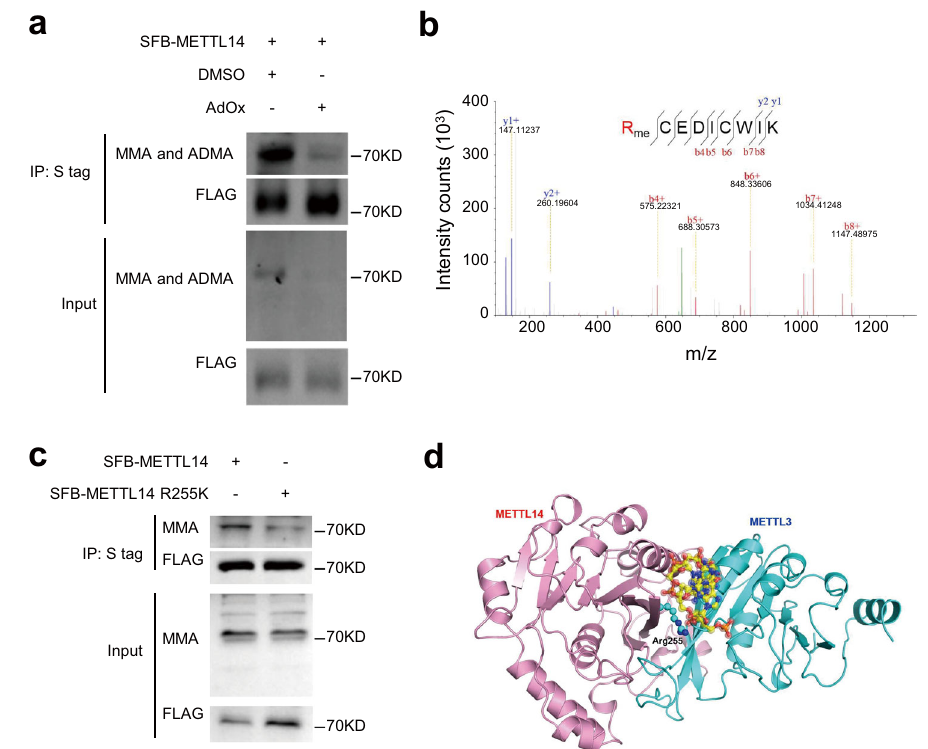
Fig. 1 METTL14 is methylated at arginine 255. a Arginine methylation of immunoprecipitated S-Flag-SBP (SFB) tagged METTL14 protein detected by western blot in HeLa cells. MMA mono-methyl arginine, ADMA asymmetric dimethyl arginine. The experiment was performed once in HeLa cells. b Mass spectrometry showing that METTL14 R255 is methylated. The mass of each b ion and y ion are shown. The mass error of the peptide identi fi cation is 0.26326 ppm. c Arginine mono-methylation of S-Flag-SBP (SFB) tagged METTL14 and METTL14 R255K proteins analyzed by western blot. Representative fi gures of three independent replicates are shown. Source data for ( a ) and ( c ) are provided as a Source Data fi le. d Crystal structure ribbon diagram indicating the position of METTL14 R255 in the METTL3 (cyan) and METTL14 (pink) heterodimer. RNA is shown as a ball-and-stick model in the